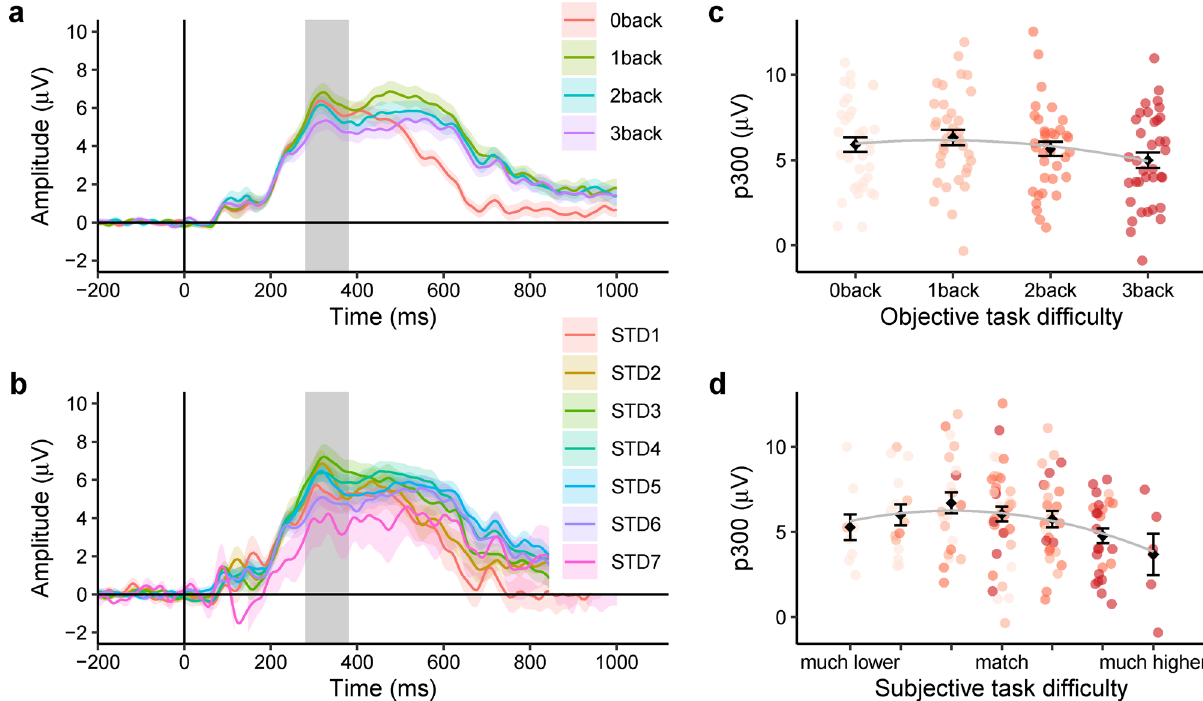
Figure 3. Stimulus-locked ERP changes in different task difficulty conditions. ( a ) Grand averaged continuous ERP waveform in four n-back tasks. ( b ) Grand averaged continuous ERP waveform in seven subjective task difficulty groups ( STD subjective task difficulty). The grey shading indicates the time window where we extract the P300 amplitude value. ( c ) Quadratic relationship between objective task difficulty and EEG P300 amplitude. ( d ) Quadratic relationship between subjective task difficulty and EEG P300 amplitude. The means ± standard errors are